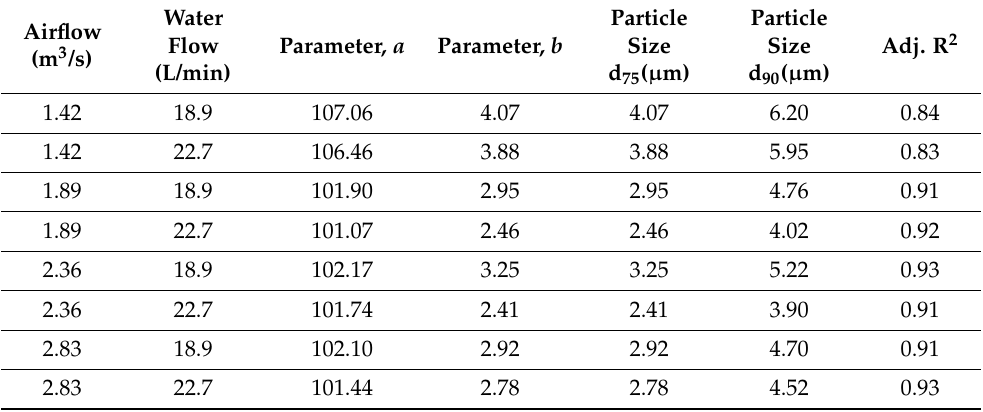
Figure 8. Exponential growth to maximum curve fit for 1.89 m 3 /s (water flow being 18.9 L/min). Table 1. Calculation of particle cut-off